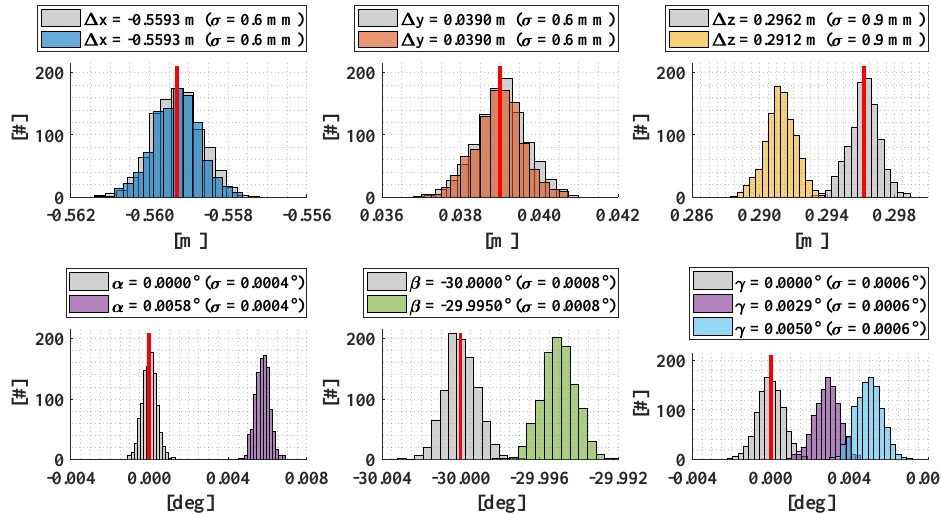
Figure 7. Distributions of the estimated calibration parameters for a Monte Carlo Simulation with 1000 realizations. The grey histograms correspond to random observation errors only (cf. Table 1, case (i)). The colored histograms correspond to random observation errors with additional systematic observation errors: δ t e = 5 mm (dark blue), δ t n = 5 mm (orange), δ t h = 5 mm (yellow), δφ = 0.005 ◦ (purple), δθ = 0.005 ◦ (green), δψ = 0.005 ◦ (light blue). The red vertical lines indicate the true